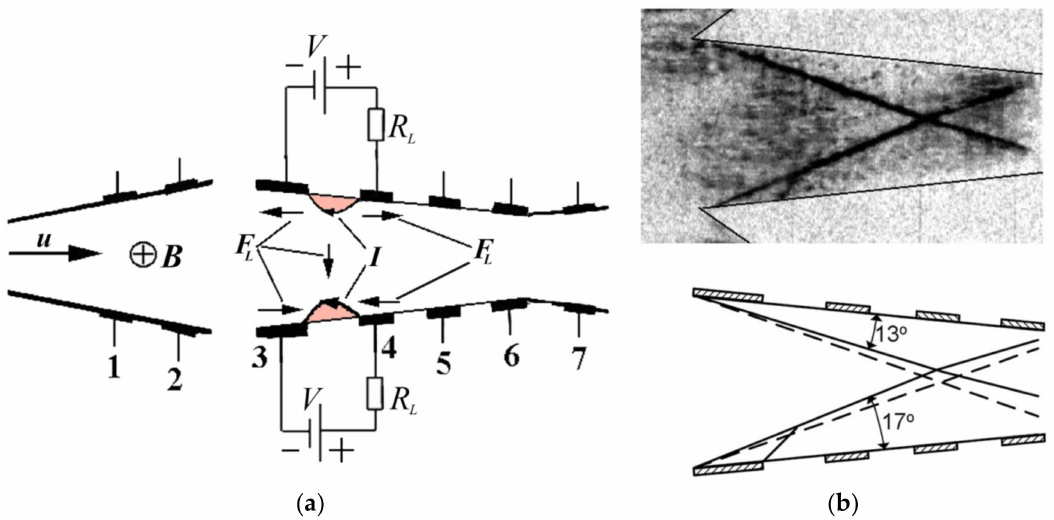
Figure 12. ( a ) Organization scheme of local longitudinal current in the inlet part of the diffuser; ( b ) Schlieren picture of the flow at longitudinal current I = 400 A, B = 1.3 T and scheme of the attached shocks